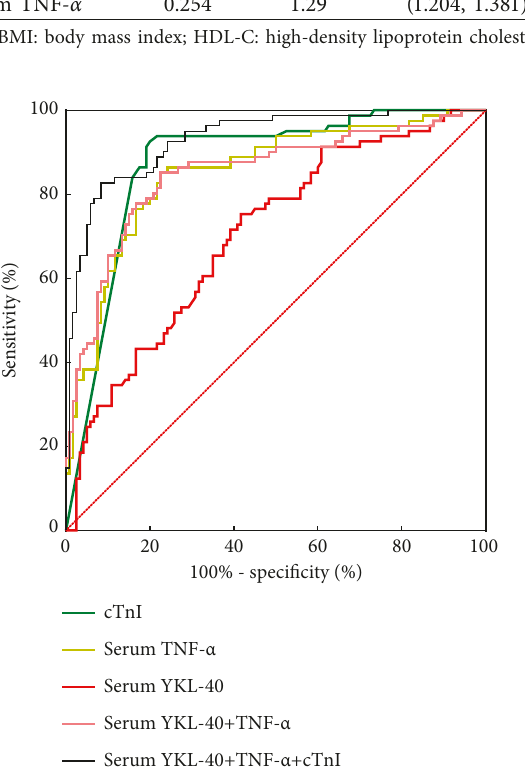
Figure 3: ROC curve of serum YKL-40 and TNF- α in the diagnosis of STEMI.